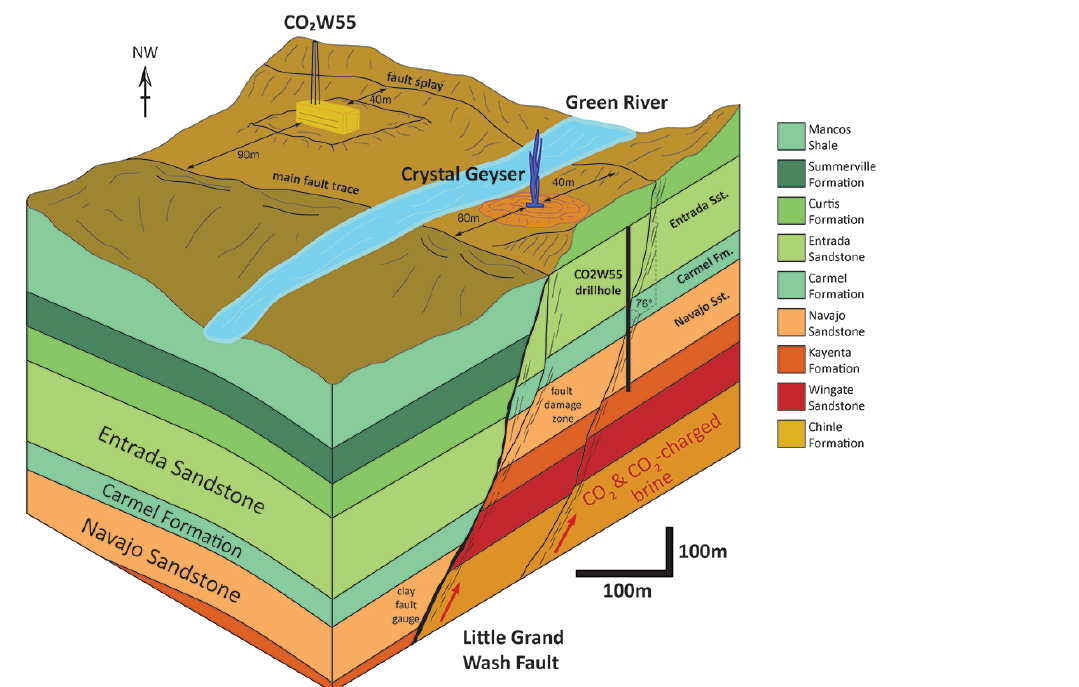
Figure 3. Cross section of the region surrounding drill hole CO2W55 showing the location of the Little Grand Wash fault system, including the northerly fault transacted by the drill hole (limited exposure precluded mapping this at surface), and the CO 2 -driven cold water geyser at Crystal Geyser. The transect taken by the drill hole is projected on the left-side of the figure. The general structure of the fault is also shown using information from field mapping and in Shipton et al. (2004) and Dockrill and Shipton (2010).